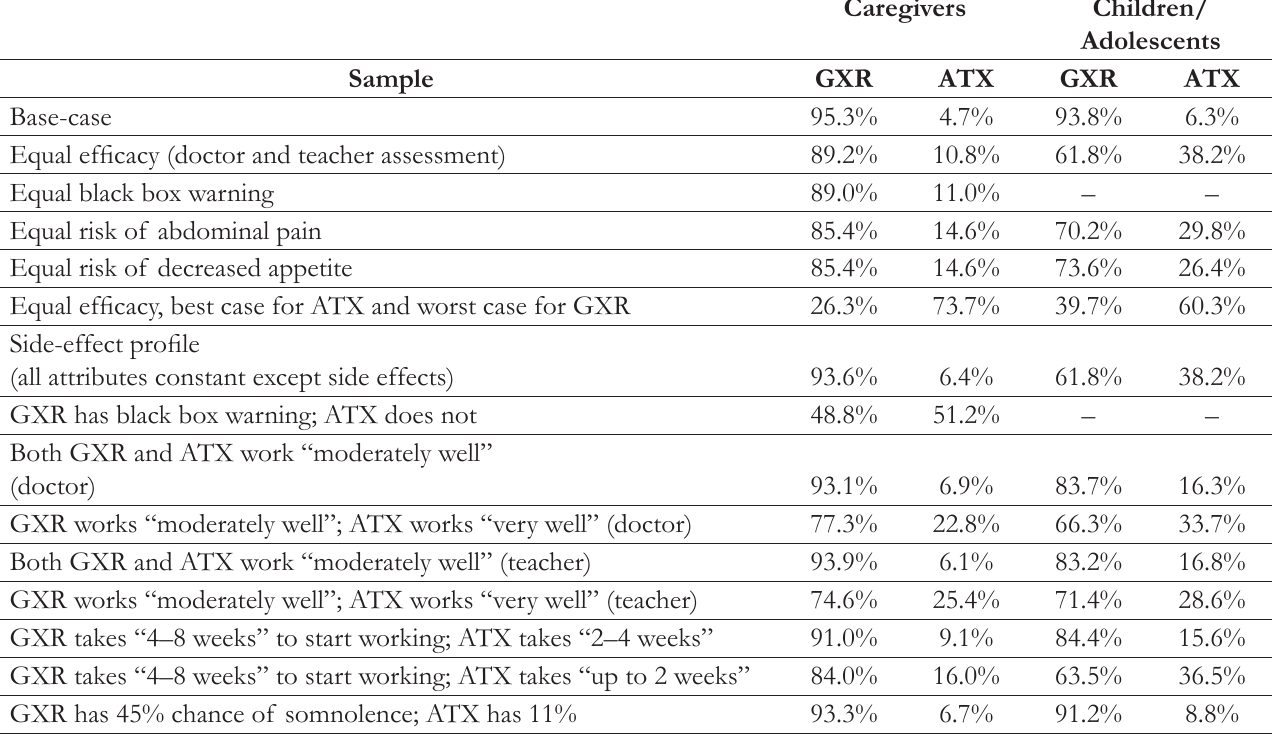
Table 3. Estimated Percentage of Caregivers and Children/Adolescents Preferring GXR over ATX (BaseCase and Sensitivity Analyses)